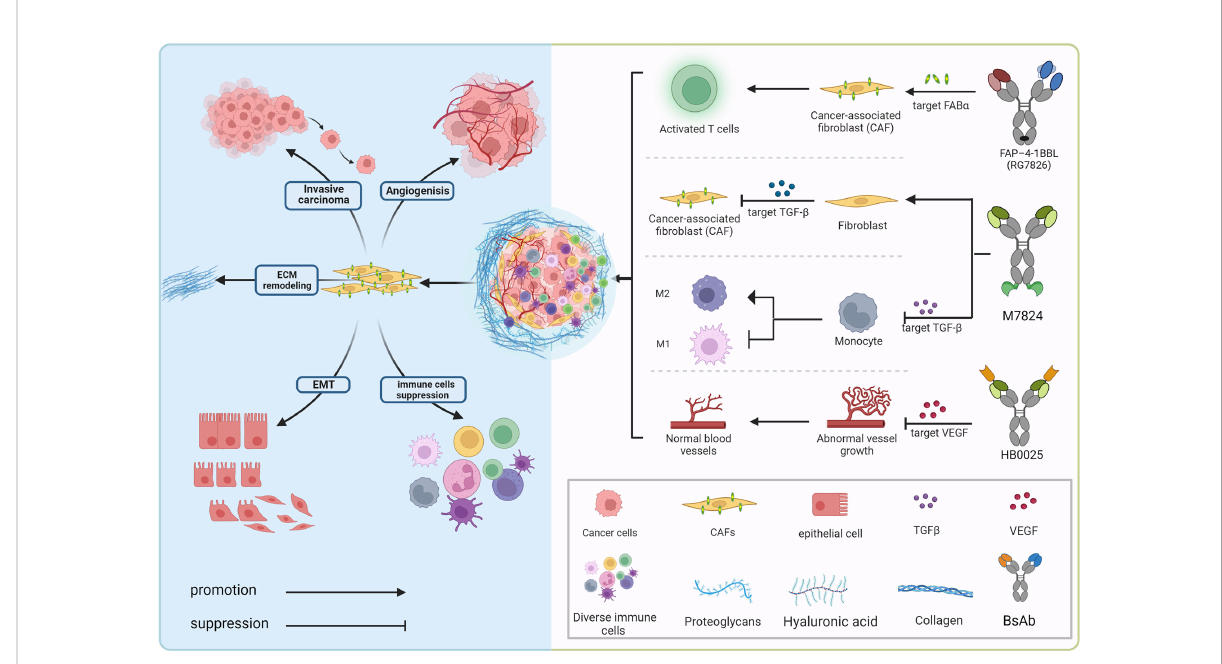
FIGURE 2 Bispeci fi c antibodies exert anti-tumor effects in the immunosuppressive tumor microenvironment. In the complex tumor microenvironment, activated fi broblasts communicate with tumor cells, various in fl ammatory cells as well as stroma cells via secreting growth factors (TGF b , VEGF, etc.) and other chemokines to provide potentially oncogenic signals and interact with the microvasculature, which induces an accelerated oncogenic extracellular-matrix microenvironment. BsAbs, aiming at blocking the interacting mechanism, transform the “ cold ” immune environment into the “ hot ” immune